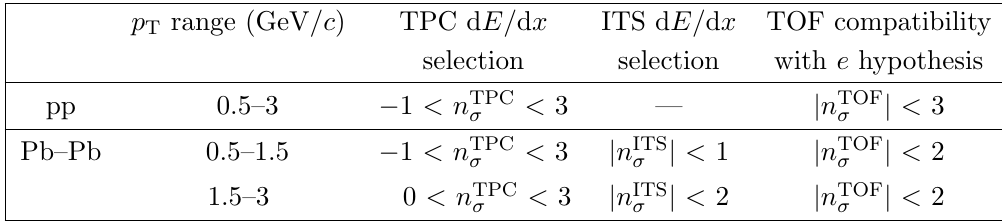
Table 3 . Electron identi(cid:12)cation criteria used in the analyses (see text for more details). contamination is negligible at the lowest p and it increases with p , reaching about 5% at T T p = 3 GeV/ c in Pb{Pb collisions and about 1% in pp collisions, with negligible dependence T on centrality and pseudorapidity. In both collision systems the hadron contamination is subtracted statistically from the inclusive electron candidate